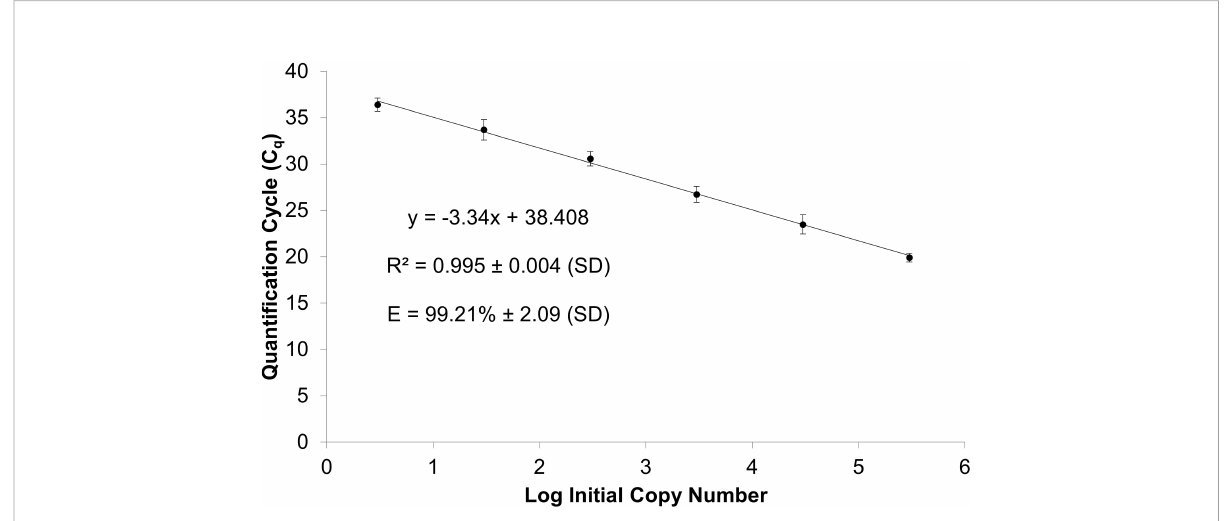
FIGURE 3 Standard curve of linearized plasmid serial dilutions containing 3 to 3 x 10 5 M. quahogii copies averaged over 5 independent trials using at least 6 replicates per run with 95% con fi dence intervals (CI). The ef fi ciency (E) and linearity (R 2 ) are expressed as the average and standard deviation (SD).